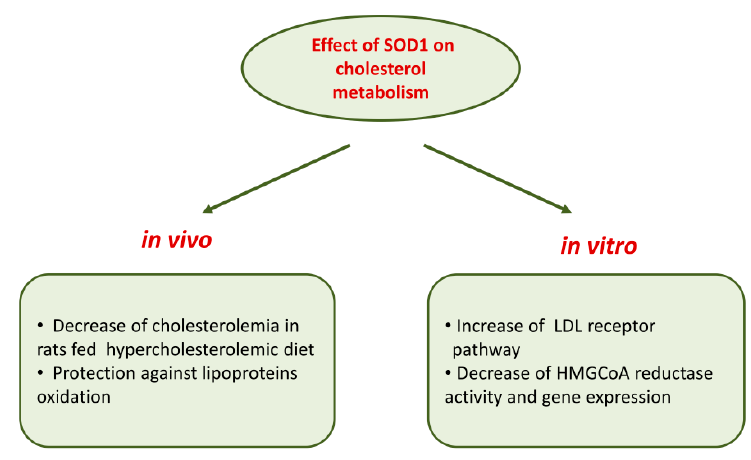
Figure 2. E ff ects of SOD1 on cholesterol